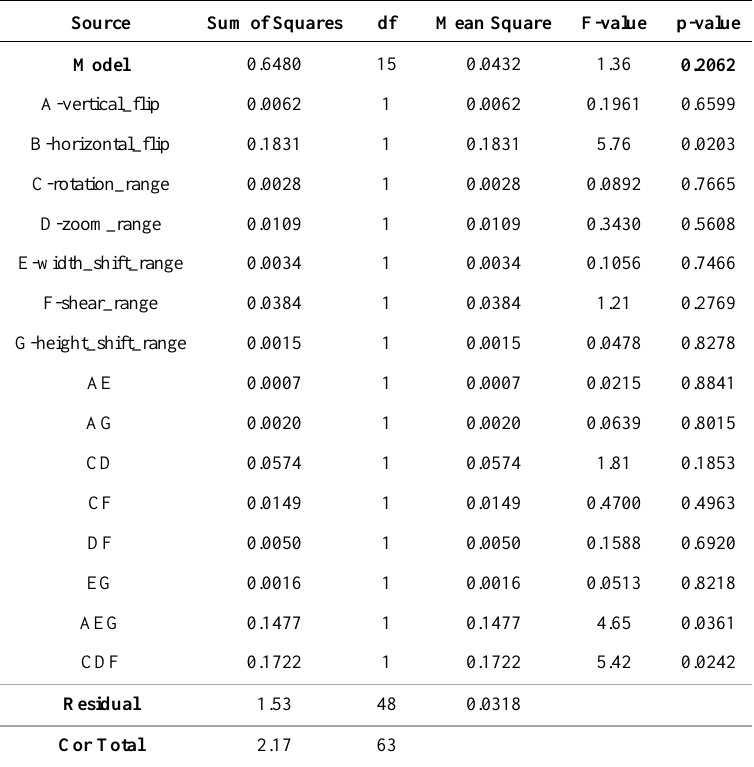
Table 7. ANOVA Results for Dataset 2